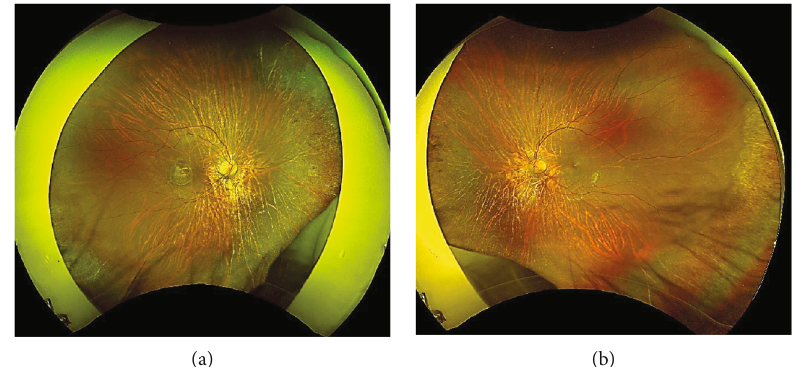
Figure 4: Right (a) and left (b) wide- fi eld fundus photographs. Note a circumferential chorioretinal atrophy in the mid-peripheral and peripheral retina.